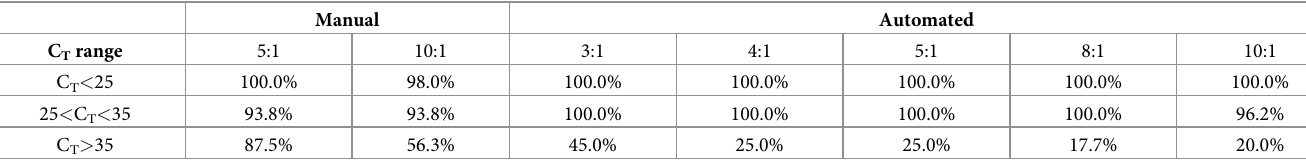
Table 4. PPA of Fusion 1 SARS-CoV-2 assay as function of neat Fusion 1 C T .